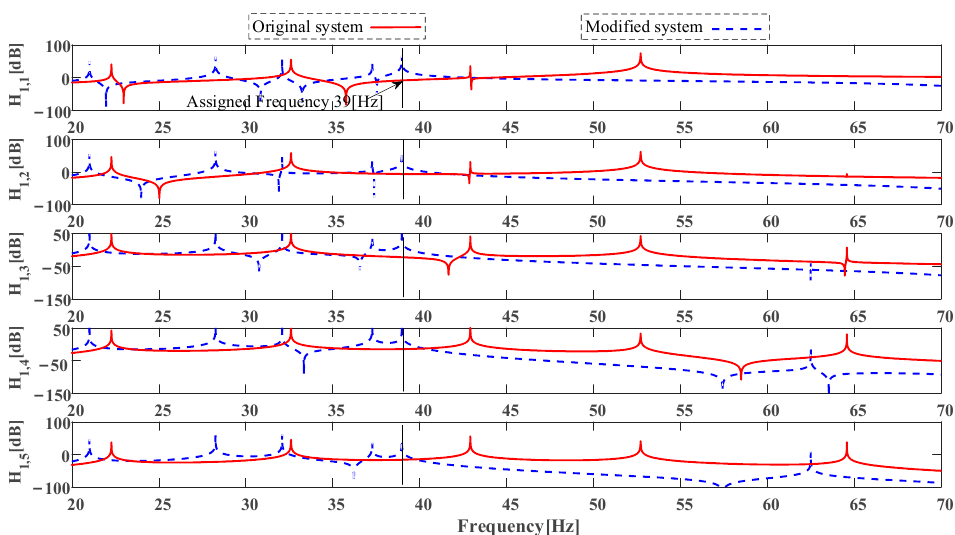
The absolute values of the receptance H 1, i ( ω ) ( i = 1, . . . , 5) of the original system (solid line) and the modified systems by the proposed method (dotted line) are shown in Figure 22. The natural frequencies and the mode obtained from the modified system are collected in Table 14. The difference between the cosine of the desired mode and the cosine of the attained mode is given in the last law of Table 14. A graphical comparison of the desired and attained modes is shown in Figure 23.